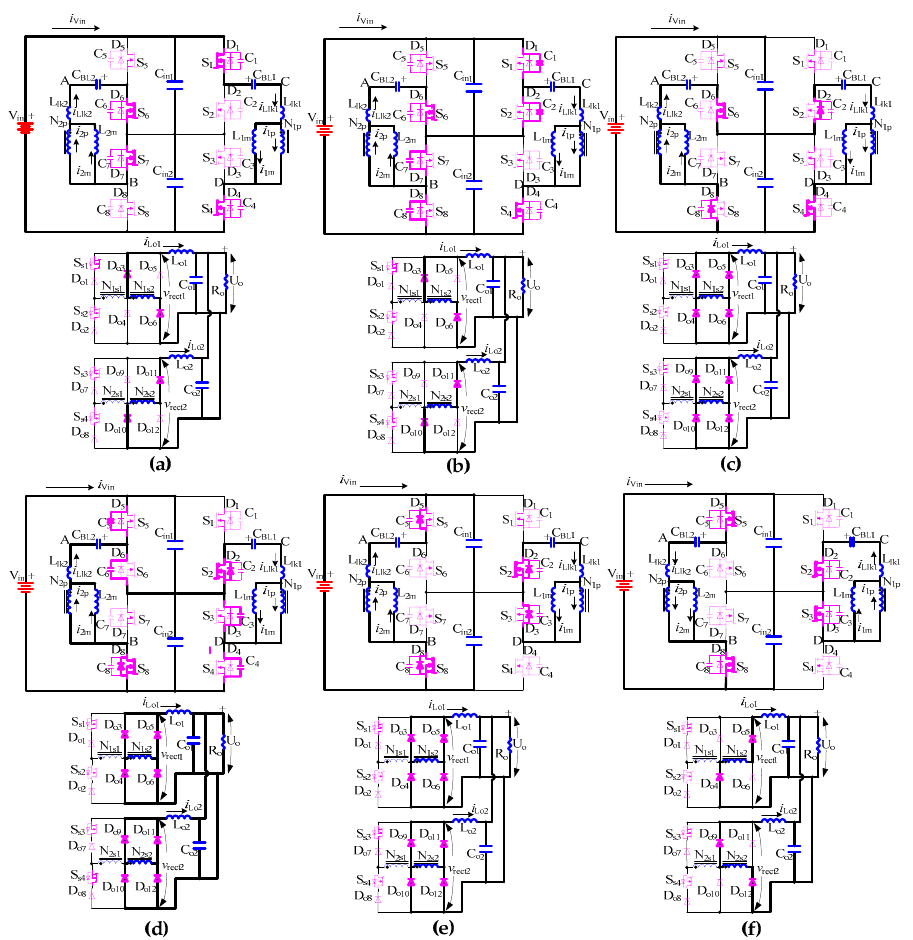
Figure 5. Operation stages of the primary side modulation mode: ( a ) stage 1; ( b ) stage 2; ( c ) stage 3; ( d ) stage 4; ( e ) stage 5; ( f ) stage 6. Table 2. Switching scheme in the first half switching period (secondary side modulation mode).